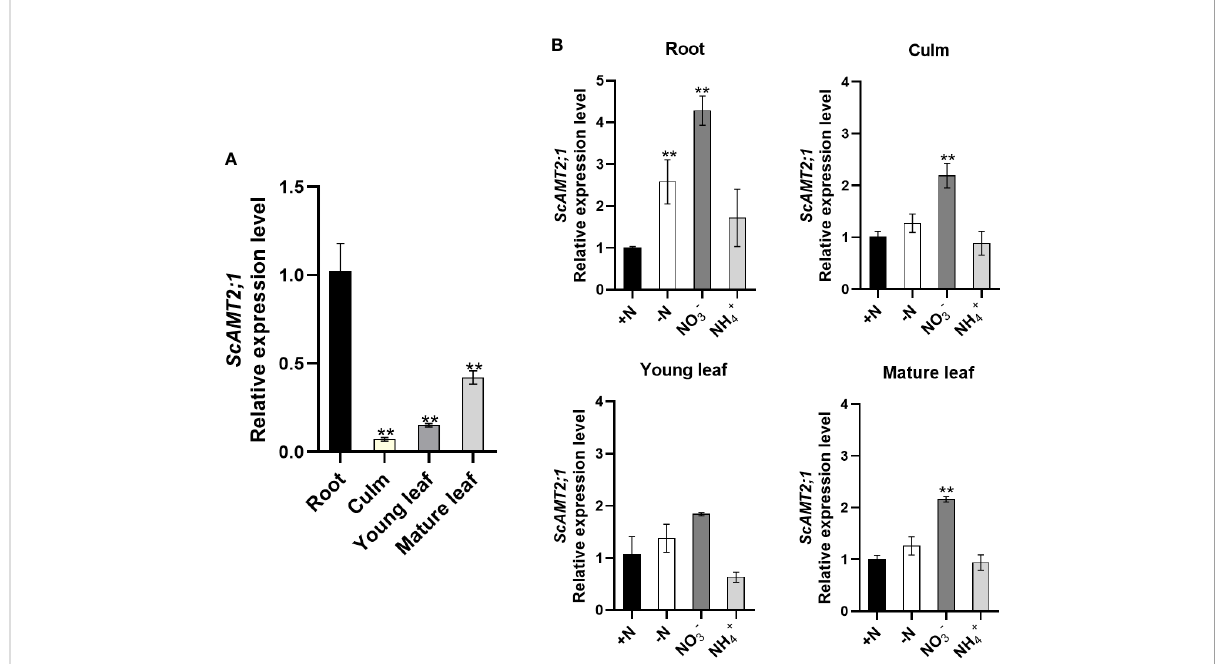
FIGURE 2 Expression of ScAMT2;1 in sugarcane organs after subjecting plants to distinct inorganic N sources or no N. (A) RT – qPCR analysis of ScAMT2;1 expression in roots, culms, and young (+1) or mature (+3) leaves of sugarcane grown under 2 mM NH 4 NO 3 for 2 d. Bars indicate ± SE ( n = 3). ScUBQ2 was adopted as a reference gene. Gene expression levels were normalized to expression levels in culms. Asterisks represent signi fi cant differences in relation to culms according to Student ’ s t test ( p < 0.01). (B) ScAMT2;1 relative expression levels in sugarcane roots, culm, young, and mature leaves of plants under +N: 2 mM NH 4 NO 3 , -N: no N; NO3-: 4 mM KNO 3 , or NH 4+ : 4 mM NH 4 Cl for 14 d. ScUBQ2 was used as a reference gene. The gene expression level was normalized to the +N treatment. Bars indicate ± SE ( n = 3). Asterisks represent signi fi cant differences between treatments and +N according to Student ’ s t test ( p <